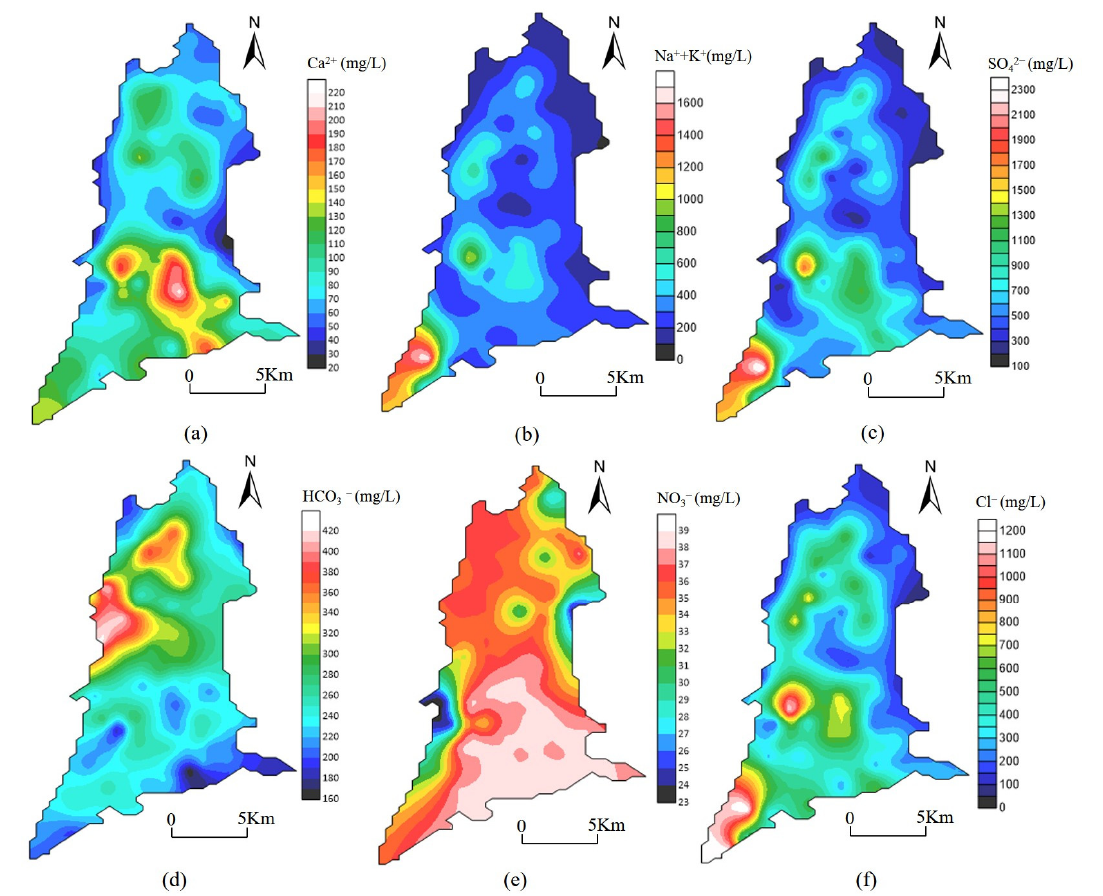
Figure 4. Spatial distribution of main ions in groundwater of Yaoba Oasis . ( a ) Ca 2+ ; ( b ) Na + +K + ; ( c )